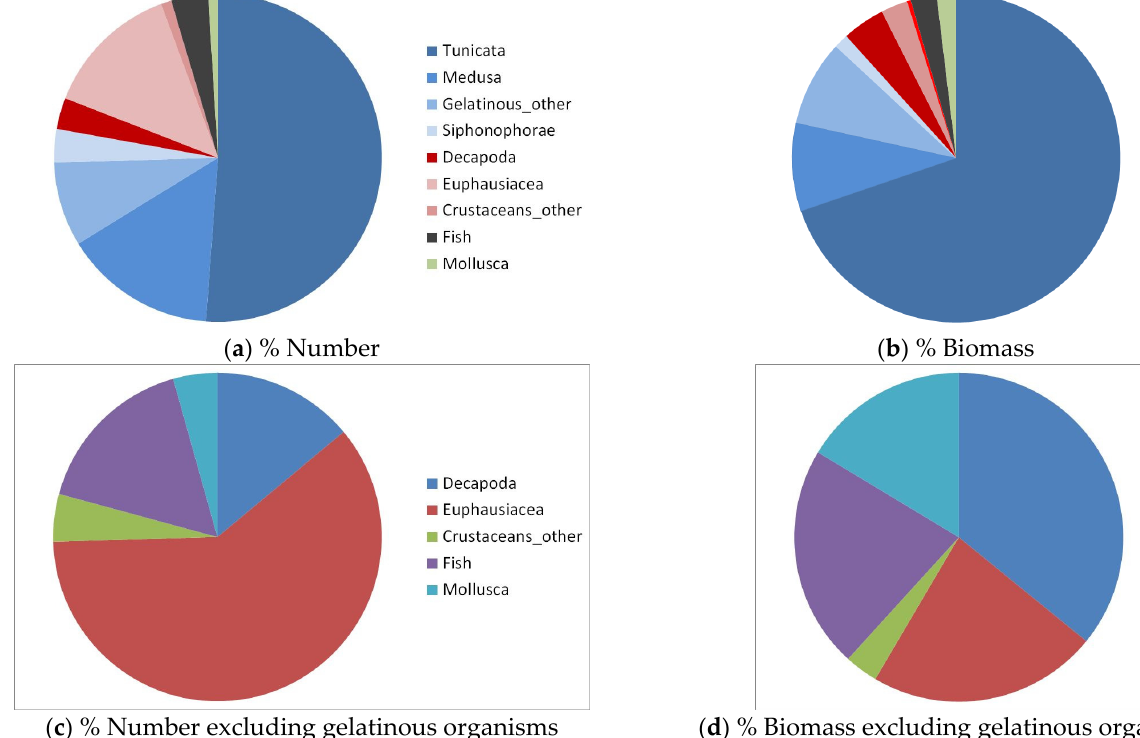
Figure 5. Relative contribution, in number ( a ) and biomass ( b ), of the main micronekton and macrozooplankton groups collected during the SUMMER-2020 cruise around the Iberian Peninsula. The vertical resolution of the VERDA system allowed for the discrimination of samples obtained from vertical strata (Figure 6), from several hundreds of meters to just 20 m. In our surveys, samples obtained on a day/night basis at different layers in the water column offered information on the night vertical displacements of fishes (almost all myctophids and some species of stomiiforms) from the mesopelagic layers (200–1000 m) where they are located during the day to the upper 100 m at night